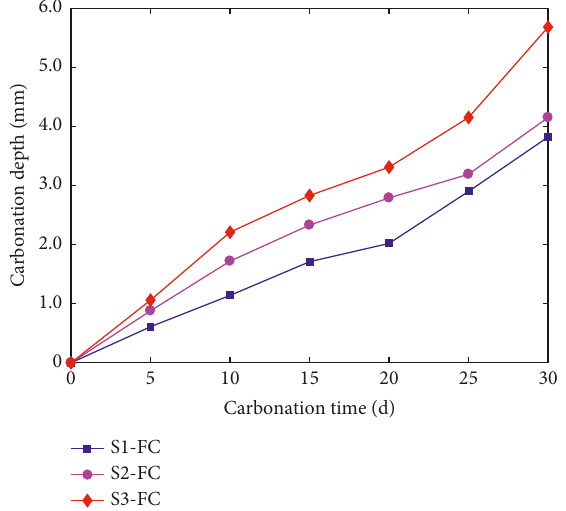
Figure 6: Carbonation velocity coefficient of S2 in different testing modes.